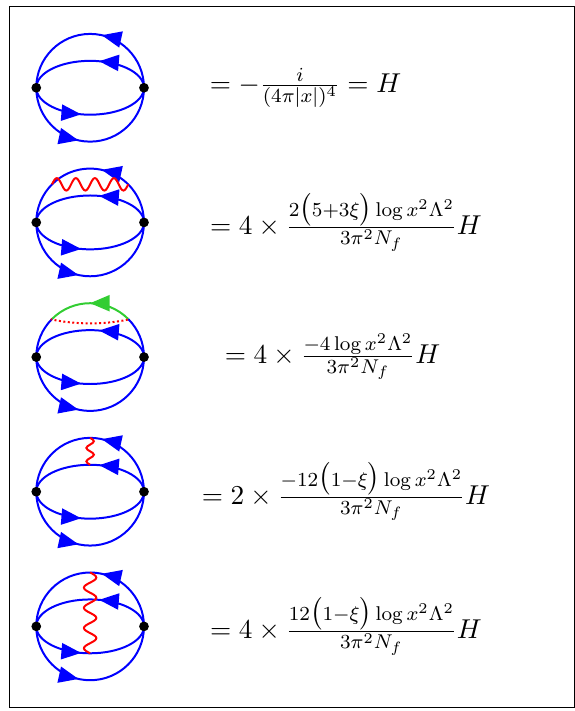
Table 14 . ( N = 1 SQED) quartic adjoint-2 operator